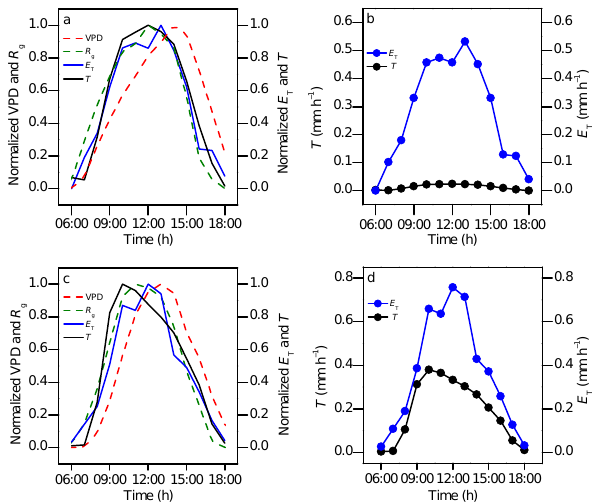
Figure 6. Normalized diurnal pattern of vapor pressure deficit (VPD), radiation ( R g ) , transpiration ( T ) and evapotranspiration ( E T ) in a 2-year old (PA) (a) and a 12-year old (PTPN6) (c) oil palm stand; absolute hourly values of E T and T in PA (b) and PTPN6 (d) . Eddy covariance and sap flux density measurements were conducted in parallel to derive evapotranspiration and transpi- ration rates, respectively. Values of three sunny days